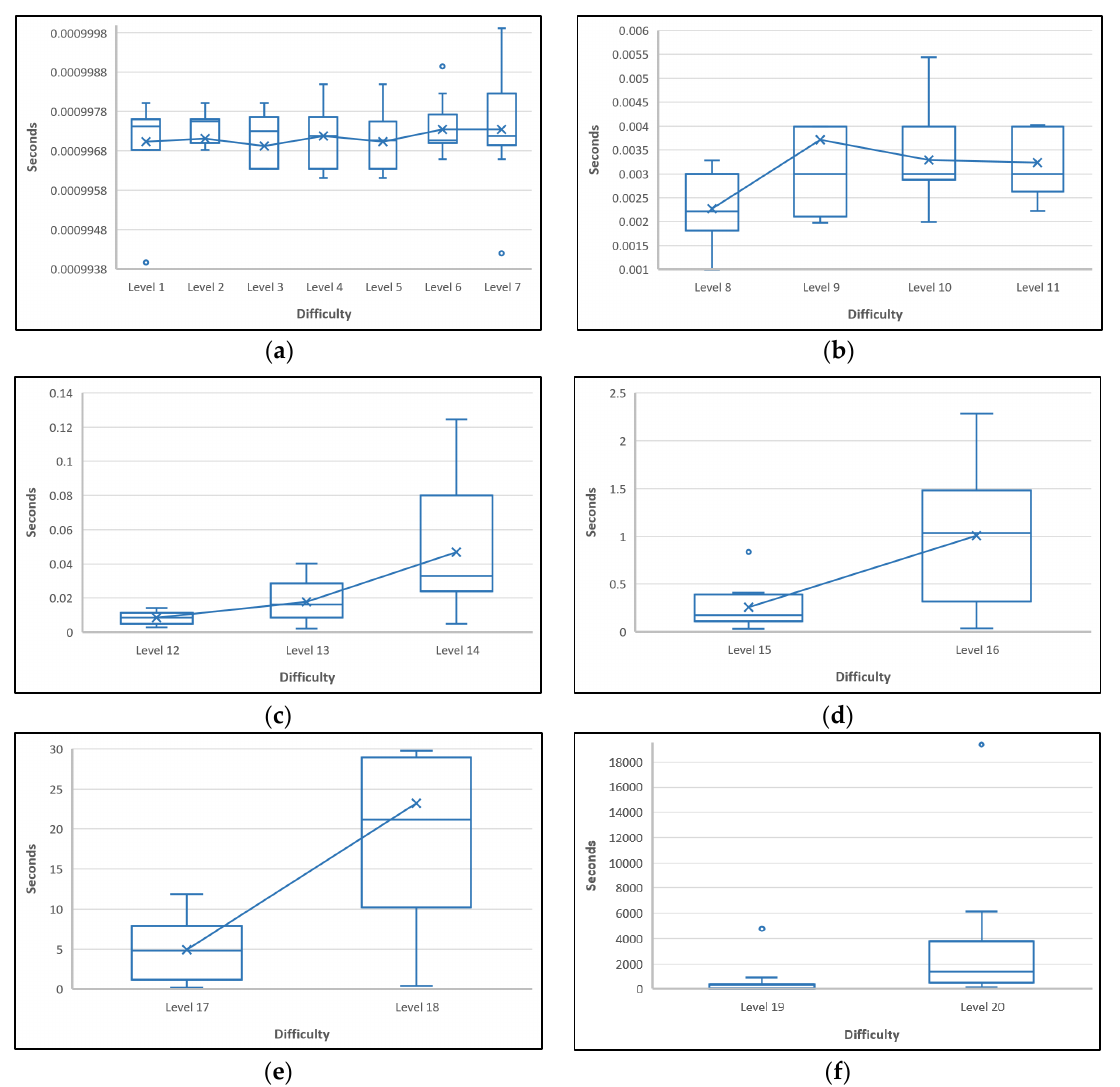
Figure 9. Block creation time using count-zero approach with difficulty level ( a ) 1–7; ( b ) 8–11; ( c ) 12–14; ( d ) 15–16; ( e ) 17–18; ( f ) 19–20.